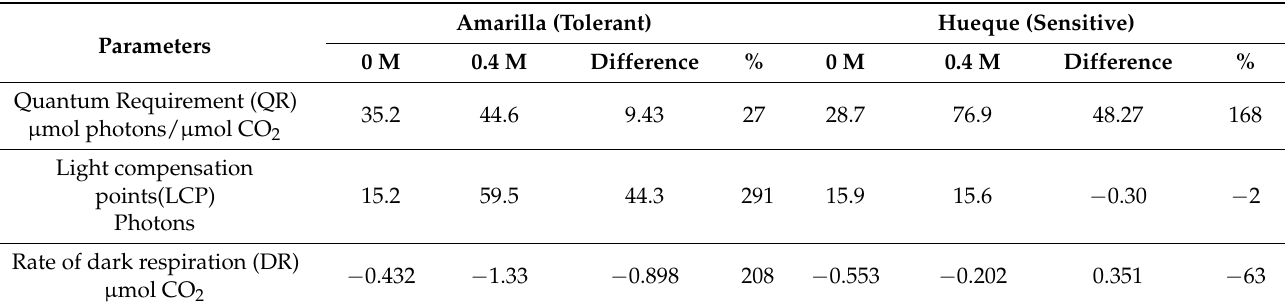
Table 8. Effect of salinity on the QR, LCP and DR of two quinoa